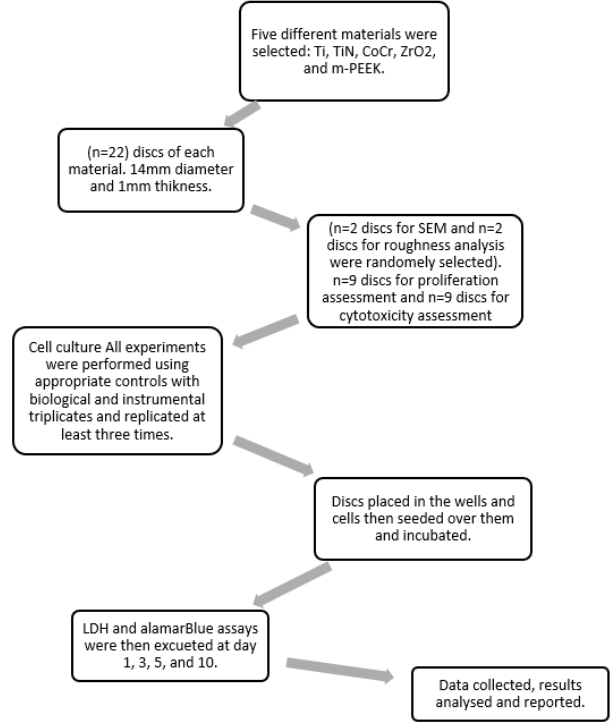
Figure 2. A flowchart illustrating the study steps.